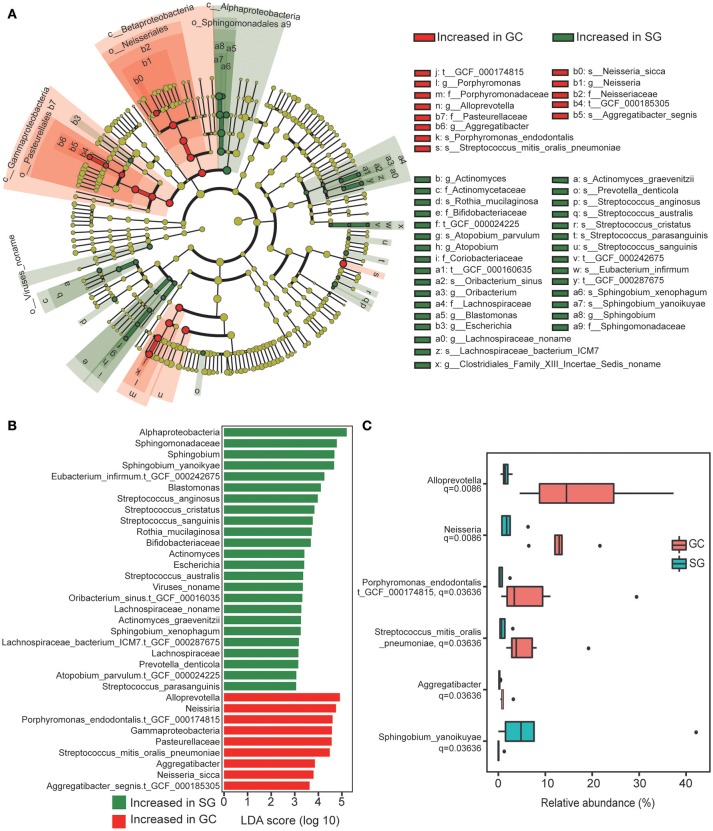
Taxonomic changes in GC microbiome. (A) Cladogram of the gastric microbial taxa associated with GC and SG. GC-enriched taxa are colored in red and SG-enriched taxa are in green. (B) Histogram of the linear discriminant analysis (LDA) scores for differentially abundant taxonomic features between GC and SG groups. Significance obtained by LDA effect size (LEfSe) at p < 0.05 (Kruksal–Wallis test) and LDAscore>2. (C) The six most representative taxa which were differentially abundant between GC and SG; Mann–Whitney U-test. P-values are adjusted by the false discovery rate (Benjamini–Hochberg FDR, q < 0.05) method; GC, advanced gastric adenocarcinoma; SG, superficial gastritis.